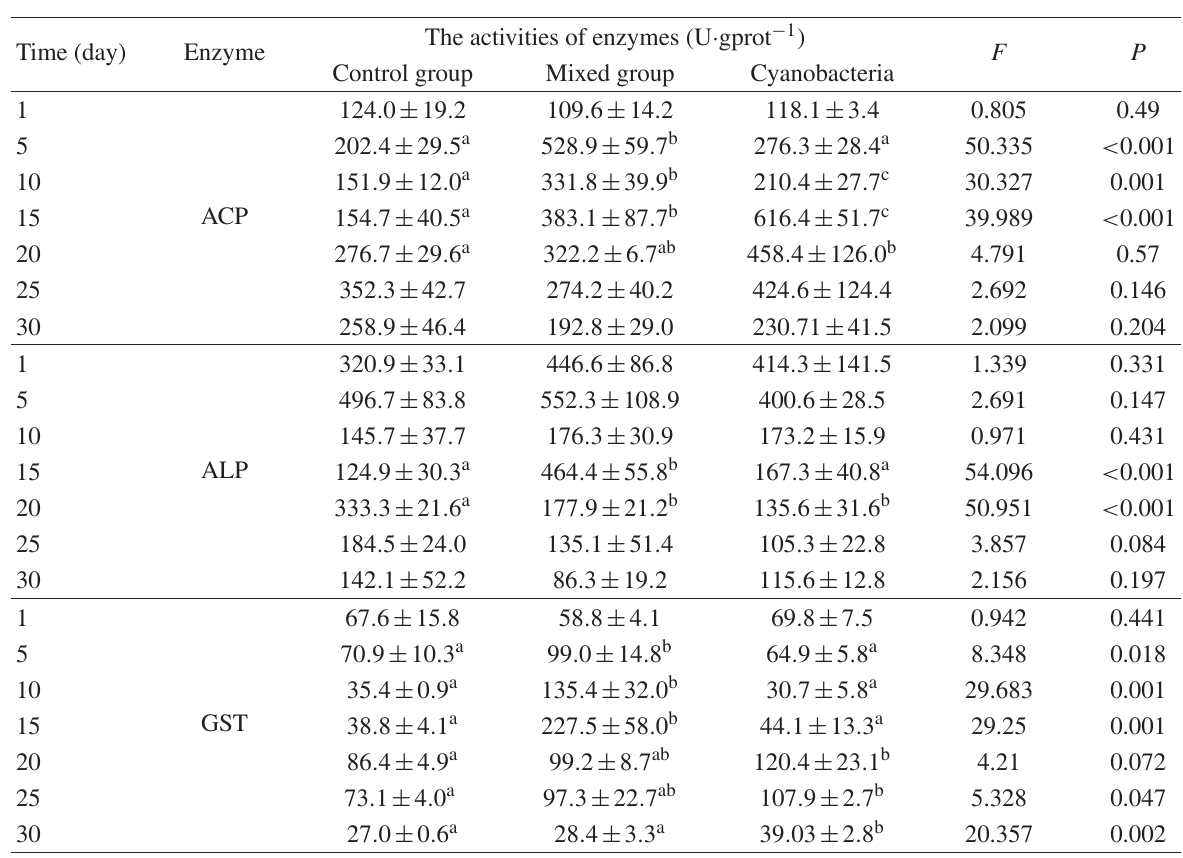
TABLE 2: The activities of enzymes ACP, ALP, and GST levels in the hepatopancreas of snails ( B. aeruginosa ) during the experiment. Results are expressed as mean ± SD. Treatments with the same superscript letter are not significantly different (Dunnett’s test, P > 0 . 05